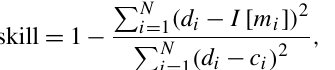
Figure 13. Seasonal air–sea CO 2 exchange at NGoM and the open GoM region among the His (historical), Bry (fixed boundary), and NoR (non-river)